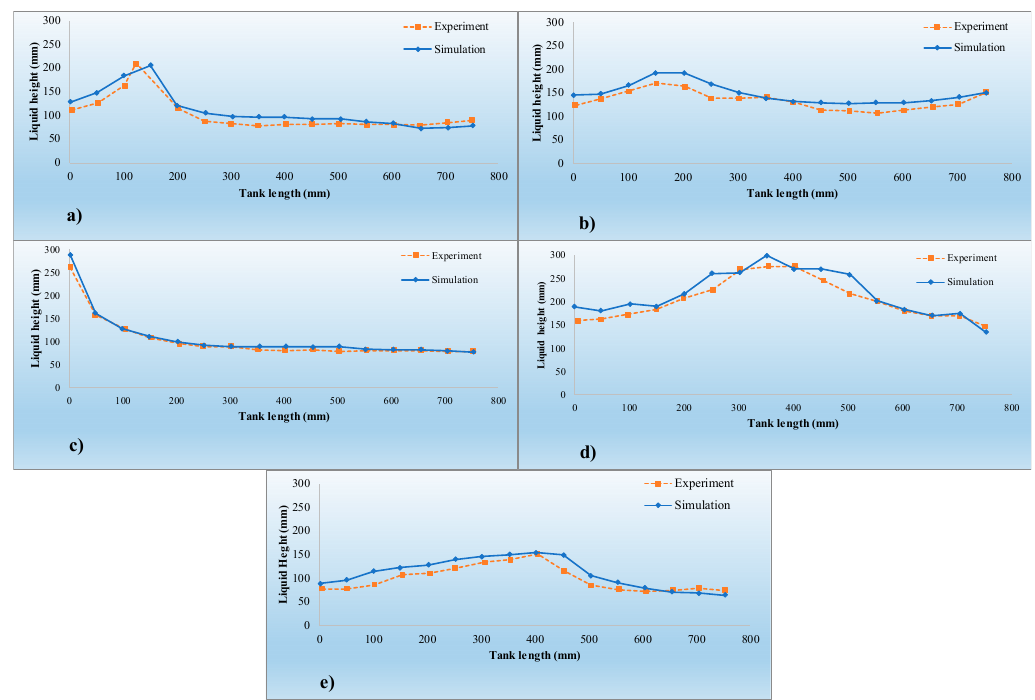
Figure 8. Comparison of free surface in numerical and experimental studies: ( a ) 100 mm water depth, 0° orientation, higher than resonance frequency, RMSE = 17.09 mm; ( b ) 100 mm water depth, 60° orientation, higher than resonance frequency, RMSE = 17.20 mm; ( c ) 100 mm water depth, 0° orientation, resonance frequency, RMSE = 8.21 mm; ( d ) 200 mm water depth, 90° orientation, higher than resonance frequency, RMSE = 19 mm; and ( e ) 100 mm of water, 30° orientation and resonance frequency, RMSE = 14.37 mm.